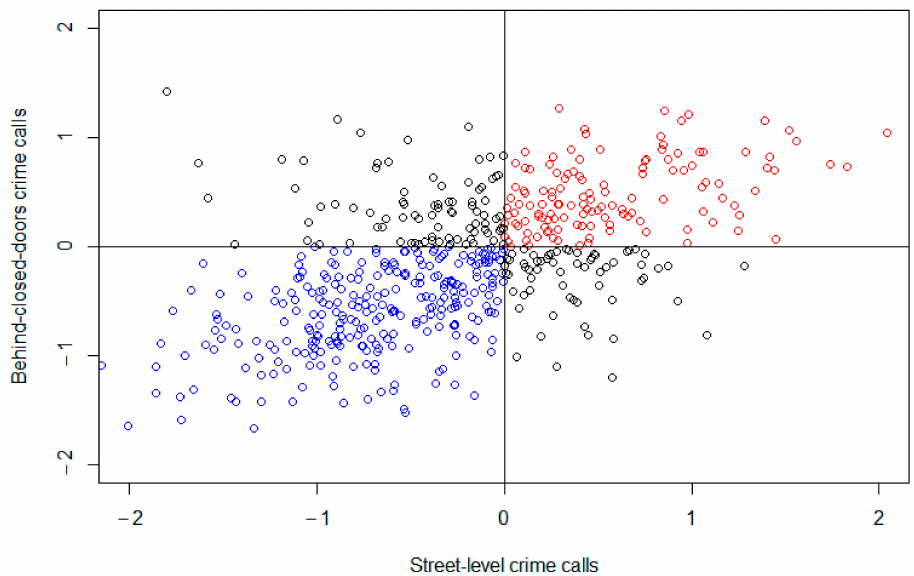
Figure 3. Scatter plot of the correlation between log relative risk for street-level and behind-closed-doors crime calls.